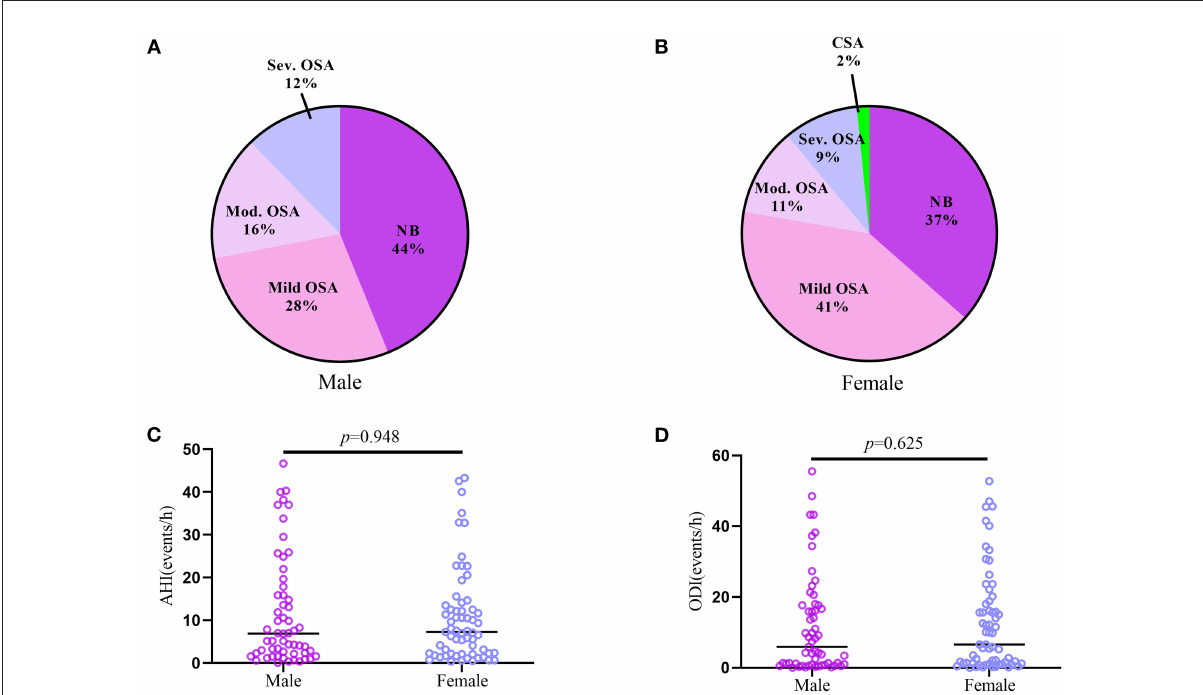
FIGURE2 The difference of SDB between Male and Female patients with CTEPH and CTEPD. (A,B) The prevalence and type of SDB in the two groups. (C,D) Male ( n = 57) and Female ( n = 63) patients had no different AHI or ODI. AHI, apnea-hypopnea index; CSA, central sleep apnea; CTEPD, chronic pulmonary thromboembolic disease; CTEPH, chronic thromboembolic pulmonary hypertension; ODI, Oxygen desaturation index; OSA, obstructive sleep